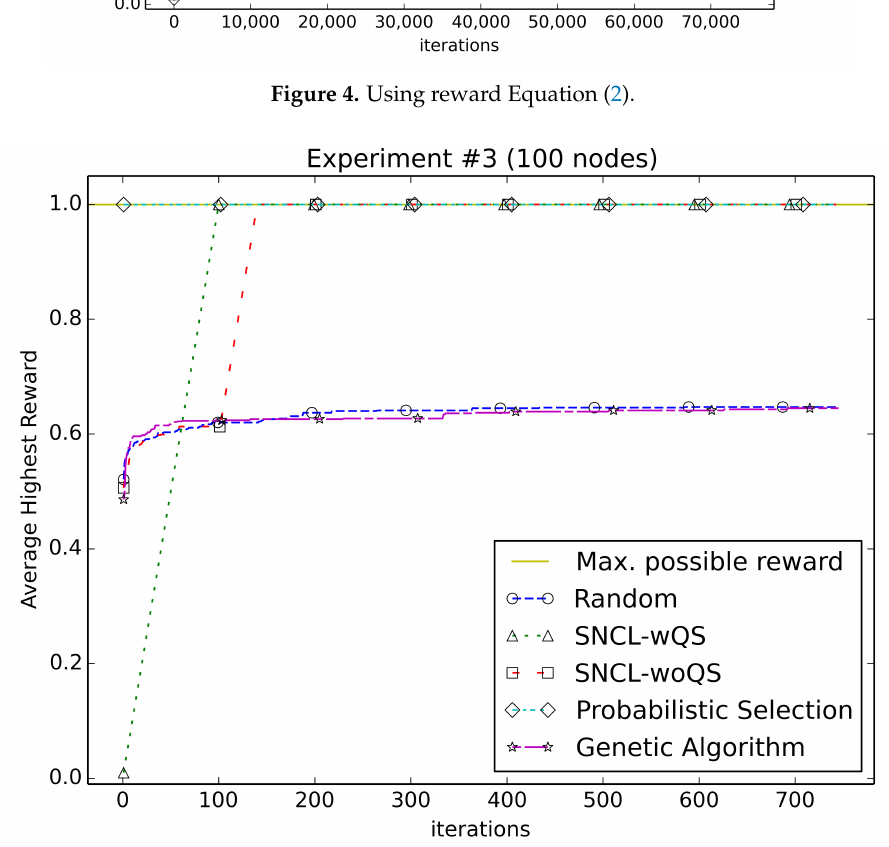
Figure 5. Using reward Equation